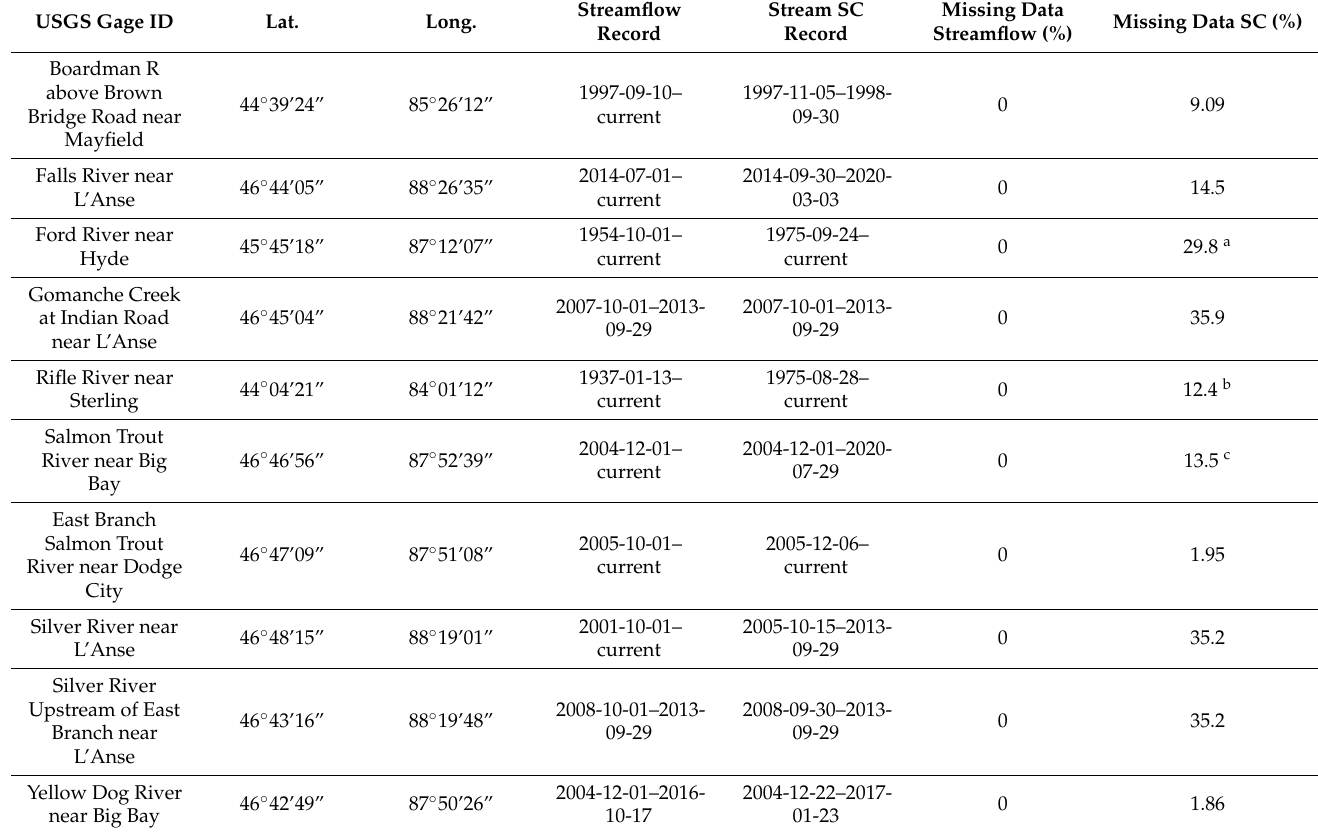
Table 1. Site locations and data